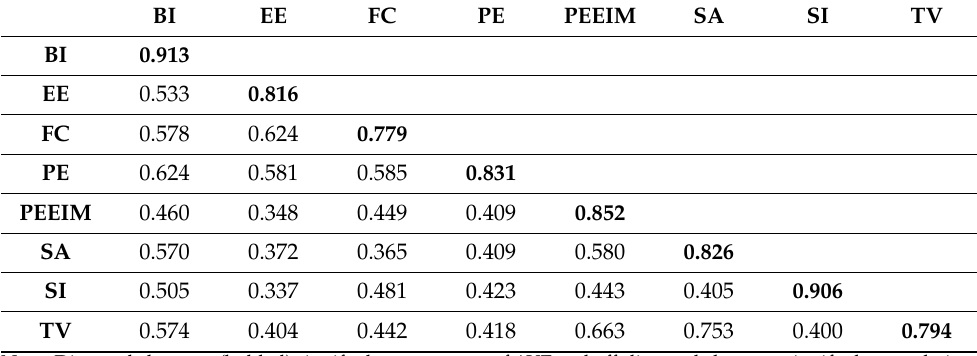
Table 3. Fornell–Larcker criterion for testing discriminant validity.